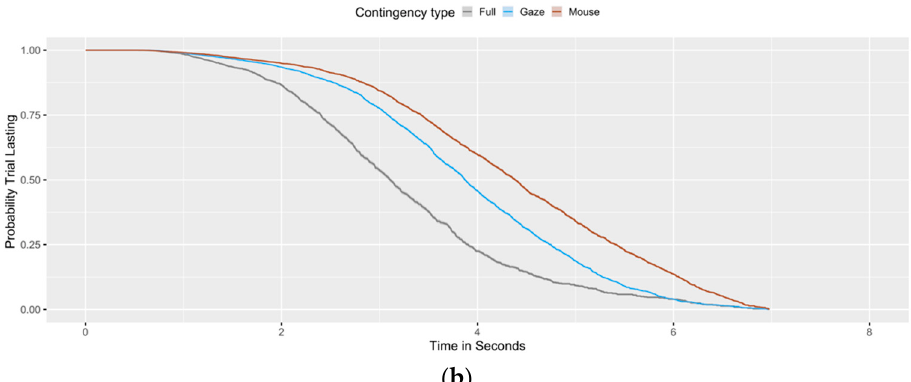
Figure 3. Overall search performance. ( a ) There were clear costs of introducing a contingent aperture as compared to fully visible conditions. As predicted, there was also a cost for a small (5 dva) compared to a large (9 dva) aperture. The additional cost of the mouse contingency over the gaze contingency was opposite to our predicted benefit of untethering mouse position and gaze. ( b ) The survival plot for target-present trials shows the probability of a trial continuing (due to the target not being found yet) past a certain time for each of the three conditions. Gaze-contingent trials diverge from mouse-contingent trials prior to the 2 second mark, and their advantage continues throughout. Box plots represent category mean (center), standard error (box), and 95% CI (whisker).